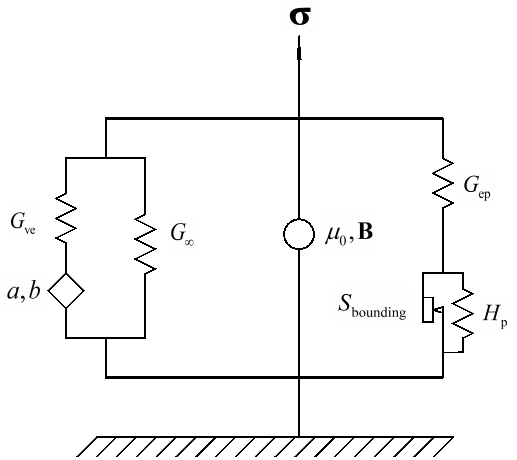
Figure 1. Rheological illustration of the constitutive